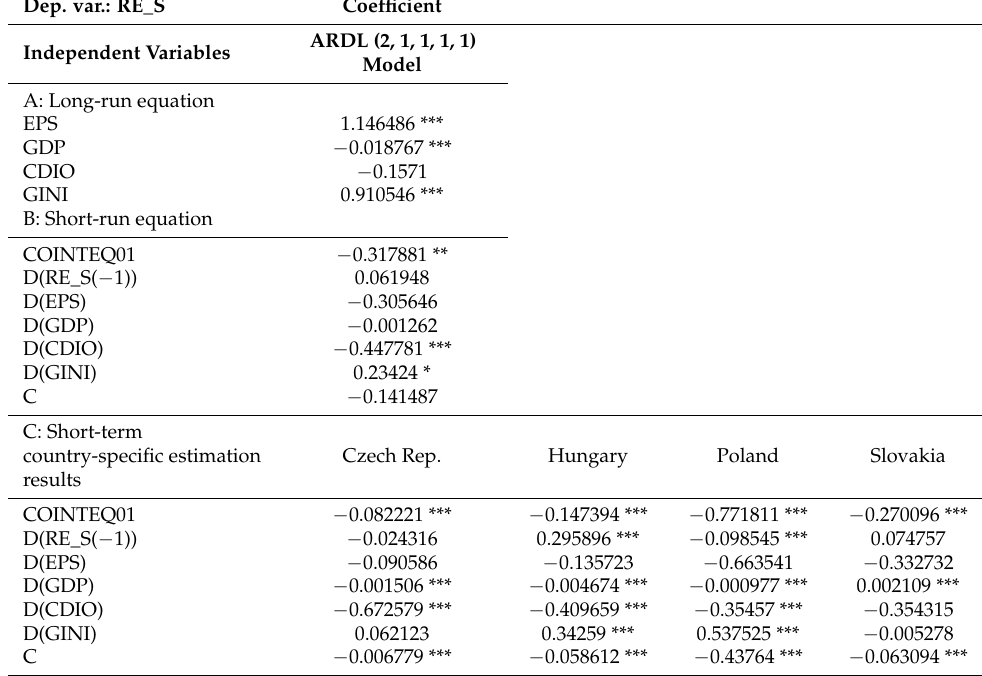
Table 17. Long-run and short-run coefficients for model